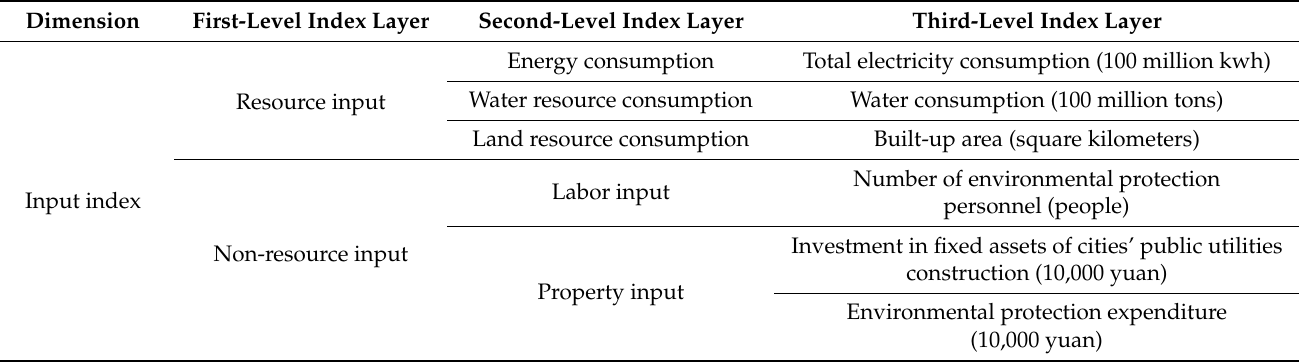
Table 2. Indicators of cities’